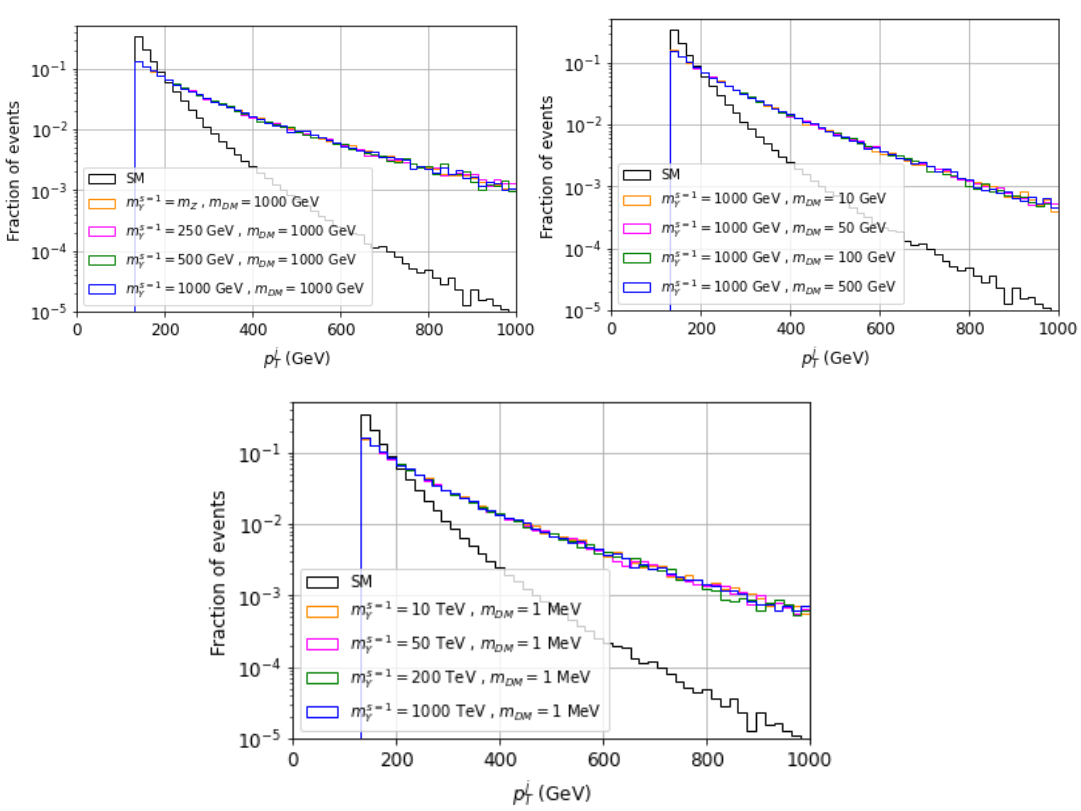
Figure 2: Spin-1 mediator framework, parton-level data. The top-left, top-right, and bottom panels show that the p j regime does not depend on m